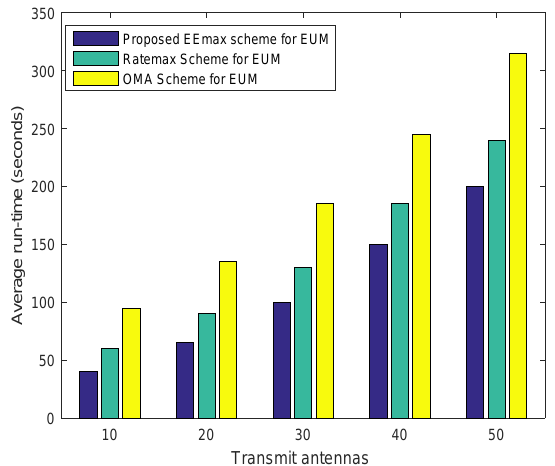
Figure 4. Average run-time versus number of transmit